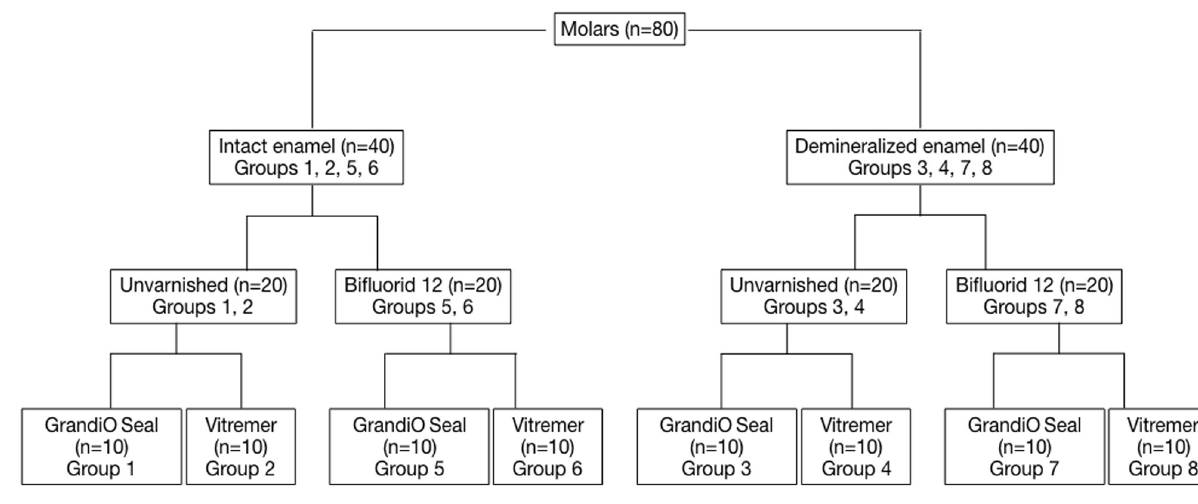
Fig 1. Flowchart of experimental groups.